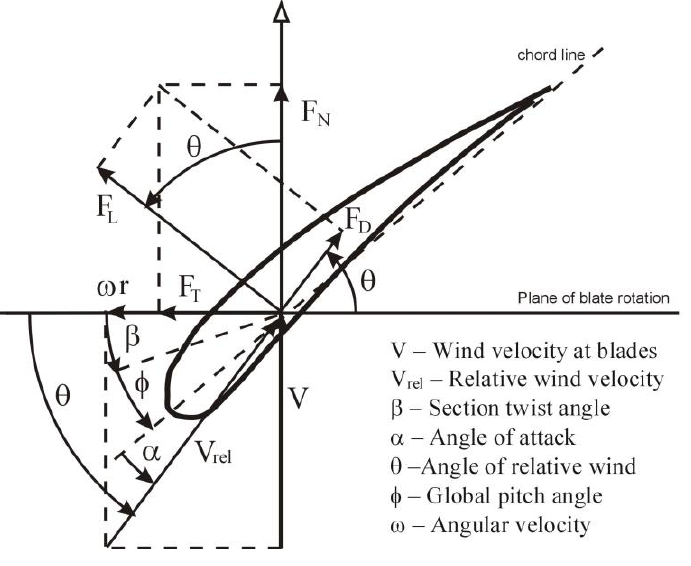
Figure 2. Aerodynamic forces on the blade profile.